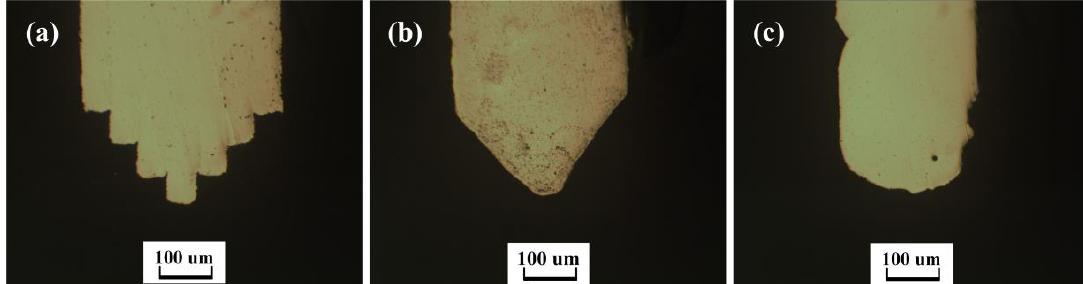
Figure 3. Schematic diagram for fabricating 3D microelectrode and microstructure.